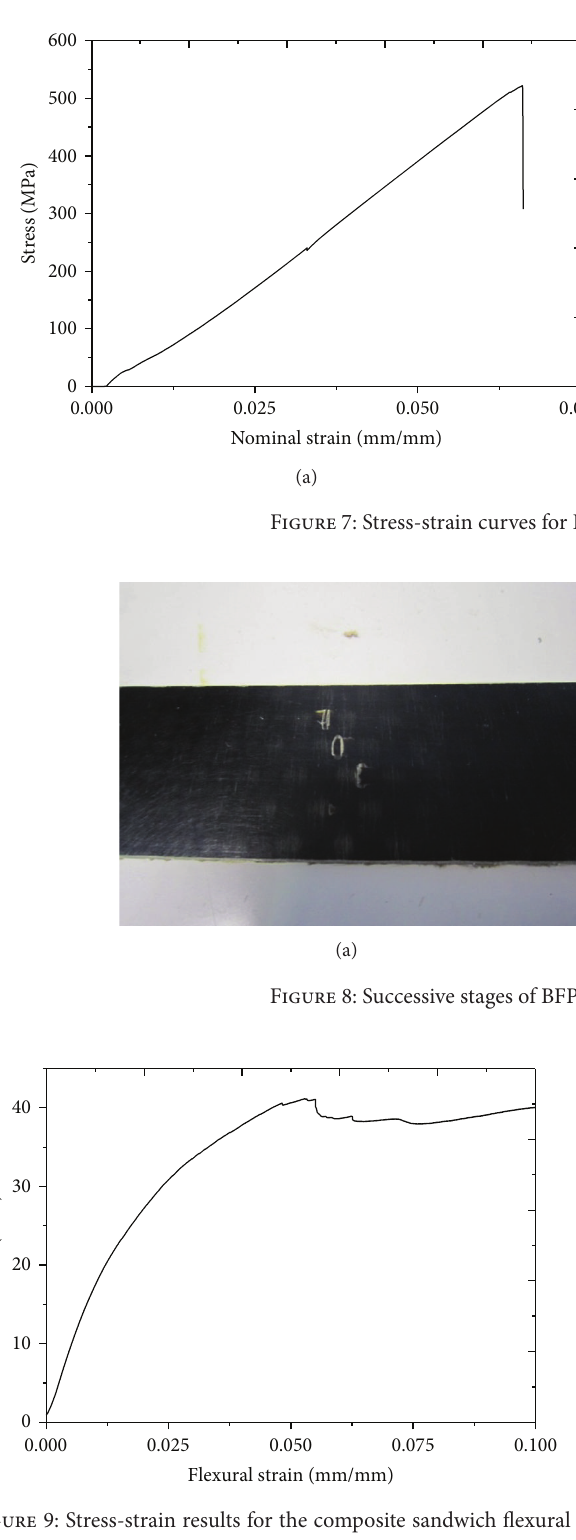
Figure 9: Stress-strain results for the composite sandwich flexural test.